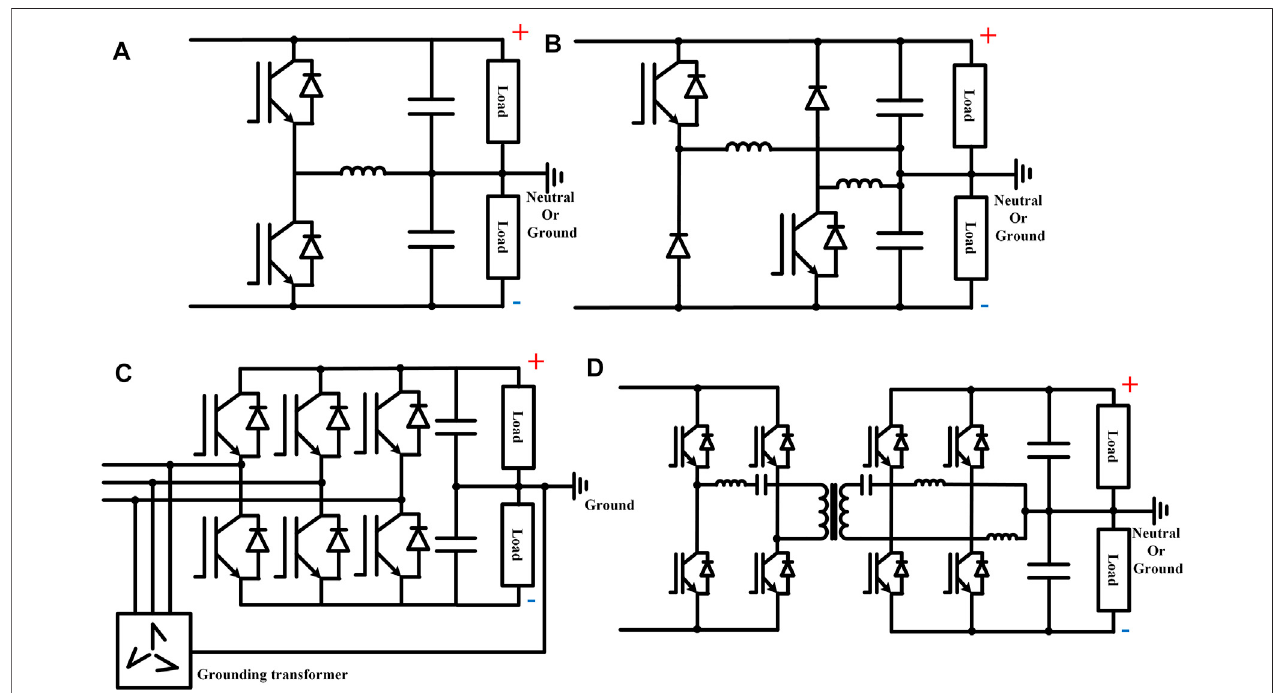
FIGURE 1 | (A) Buck/boost type in Rivera et al. (2021). (B) Dual-buck type in Rivera et al. (2021). (C) Utilization of Grounding transformer in Li et al. (2018). (D) Enhanced CLLC with bipolar balance in Li Y et al.